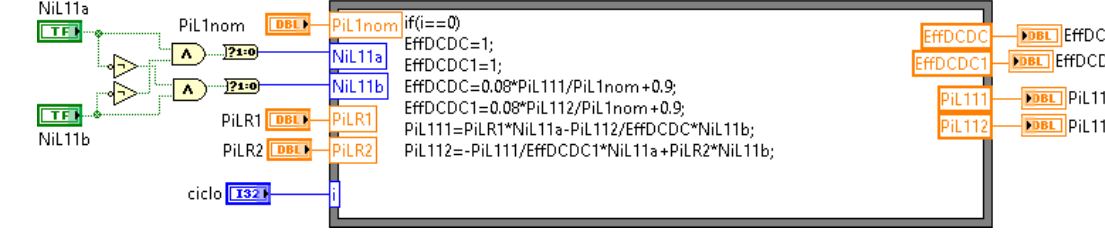
Figure 13. LabVIEW programming for ILCs.